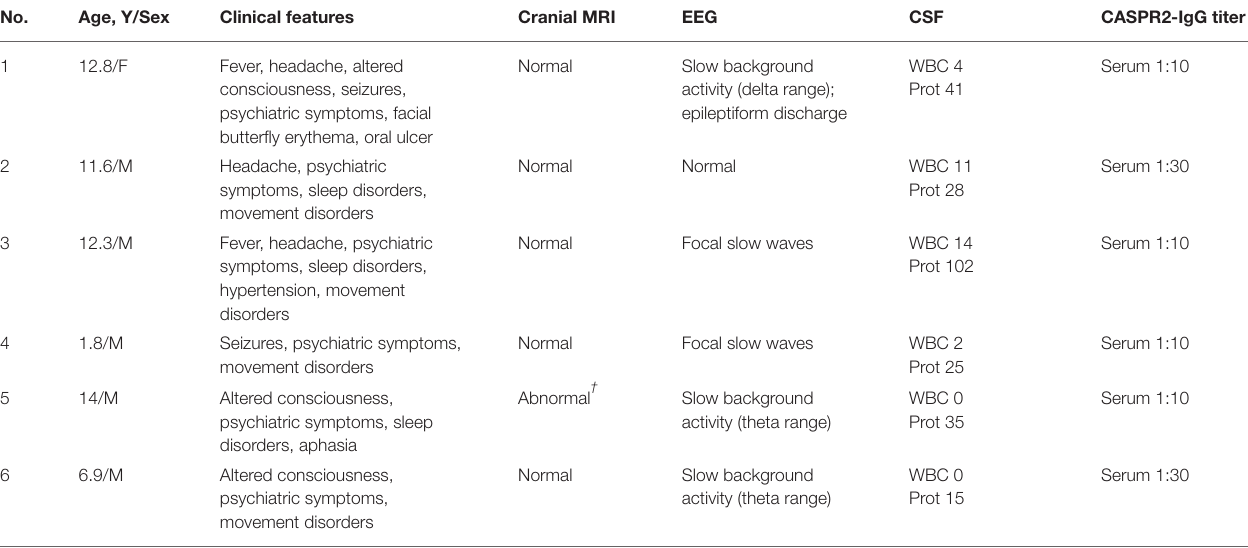
TABLE 1 | Clinical and investigatory findings of patients with positive anti-CASPR2 antibody.